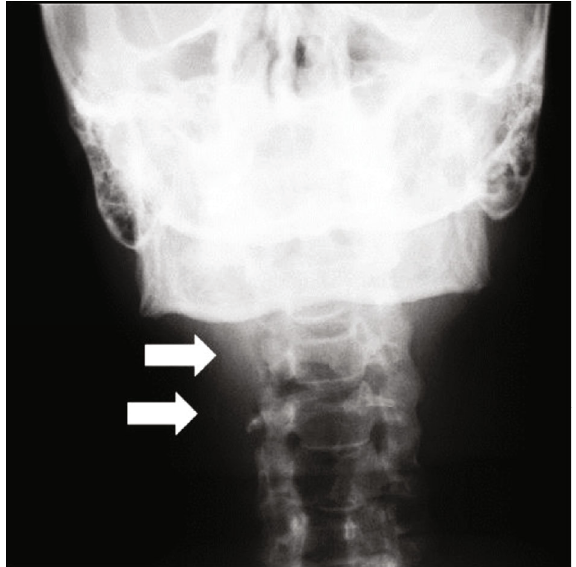
Figure 5: Manzi Projection showing the presence of two calci fi ed plaques adjacent to the cervical region (arrows).